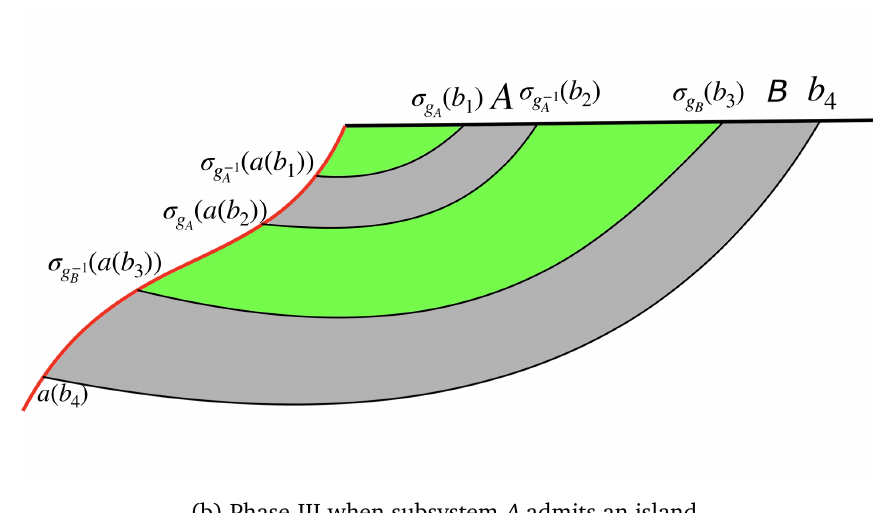
Figure 10: Schematic of the island proposal-II for the entanglement negativity of the mixed state configuration of the disjoint intervals in